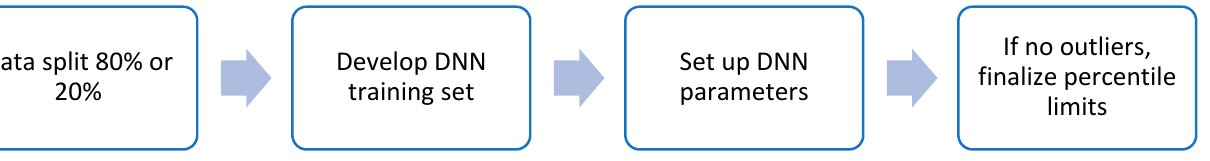
Figure 2. Visualization of the steps needed for the Winsorization process of MHC Class I epitopes. We first split the data using an 80–20 ratio to set up a training set. This was followed by developing the DNN with the same number of Hidden Layers corresponding to the amount of reference data. We used an Adam algorithm and a Xavier initialization method to set up the DNN parameters, including learning rate, optimizers, epochs, and batch size. This process was repeated until all outliers within the selected range were eliminated. Once no outliers were present, we continued training the DNN by finalizing the upper and lower percentile fences. We used these same steps for in-house datasets, albeit with a 90:10 training-to-test ratio instead of